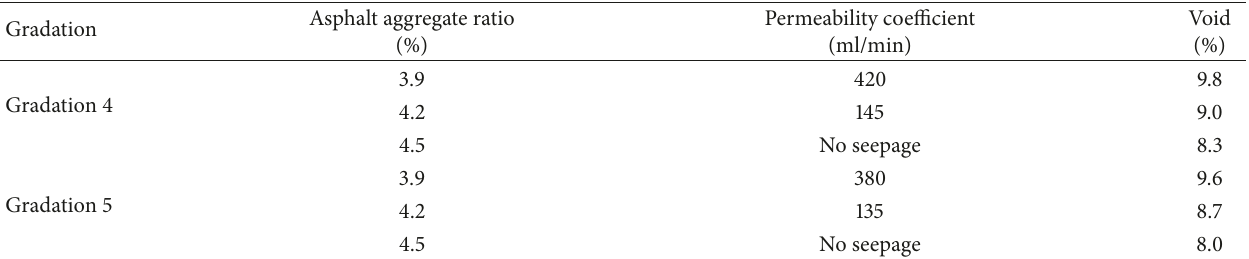
Table 12: Permeability coefficient and voids of